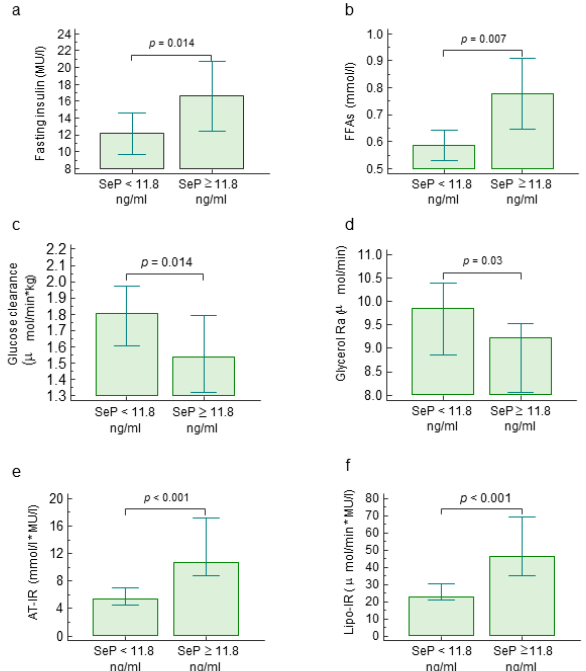
Figure 1. Metabolic parameters and insulin resistance components according to selenoprotein p values. Fasting insulin levels ( a ), free fatty acid (FFA) levels ( b ), glucose clearance ( c ) lipolysis ( d ), adipose tissue insulin resistance (IR) by FFAs ( e ) and by glycerol rate of appearance (Ra) ( f ) are reported according to selenoprotein P cut-off, corresponding to the 75th percentile (11.8 ng/mL). Abbreviations: adipose tissue (AT), free fatty acids (FFAs), insulin resistance (IR), rate of appearance (Ra), selenoprotein P (SeP).